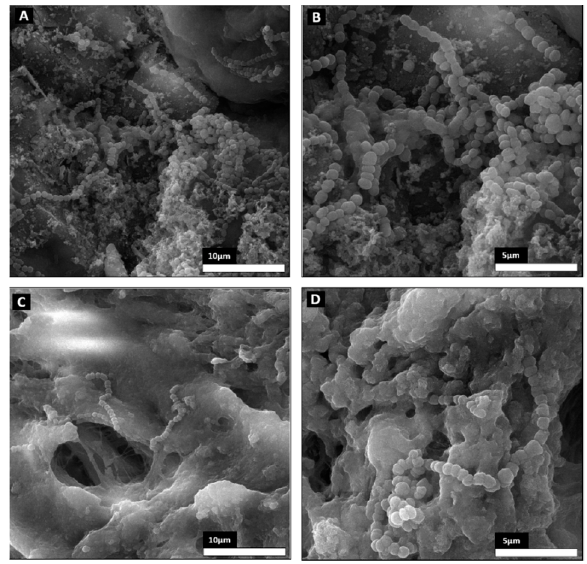
Figure 7. SEM images of S. mitis biofilm on the surfaces of ( A , B ) control collagen membranes and ( C , D ) CHI–HAp–collagen membranes. Scale bars: 5 µ m and 10 µ m, magnifications 10,000 × and 5000×, respectively.